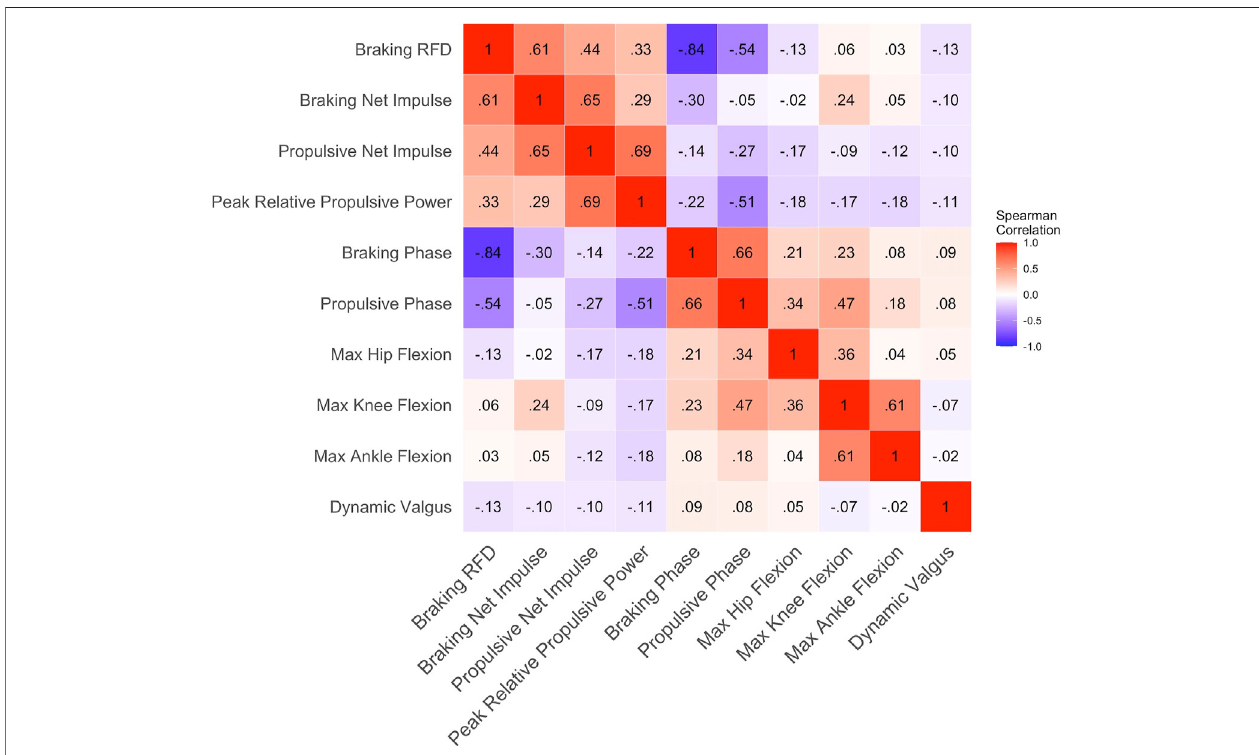
FIGURE2 | Correlationplot on the10 variables used for k-means clustering; r values represented byvalue and color representation (darker red = greater positive r values and darker blue = greater negative r values); If pairwise r values were > 0.85 and < − 0.85 then one variable of the pairwise variables were removed; No variables were